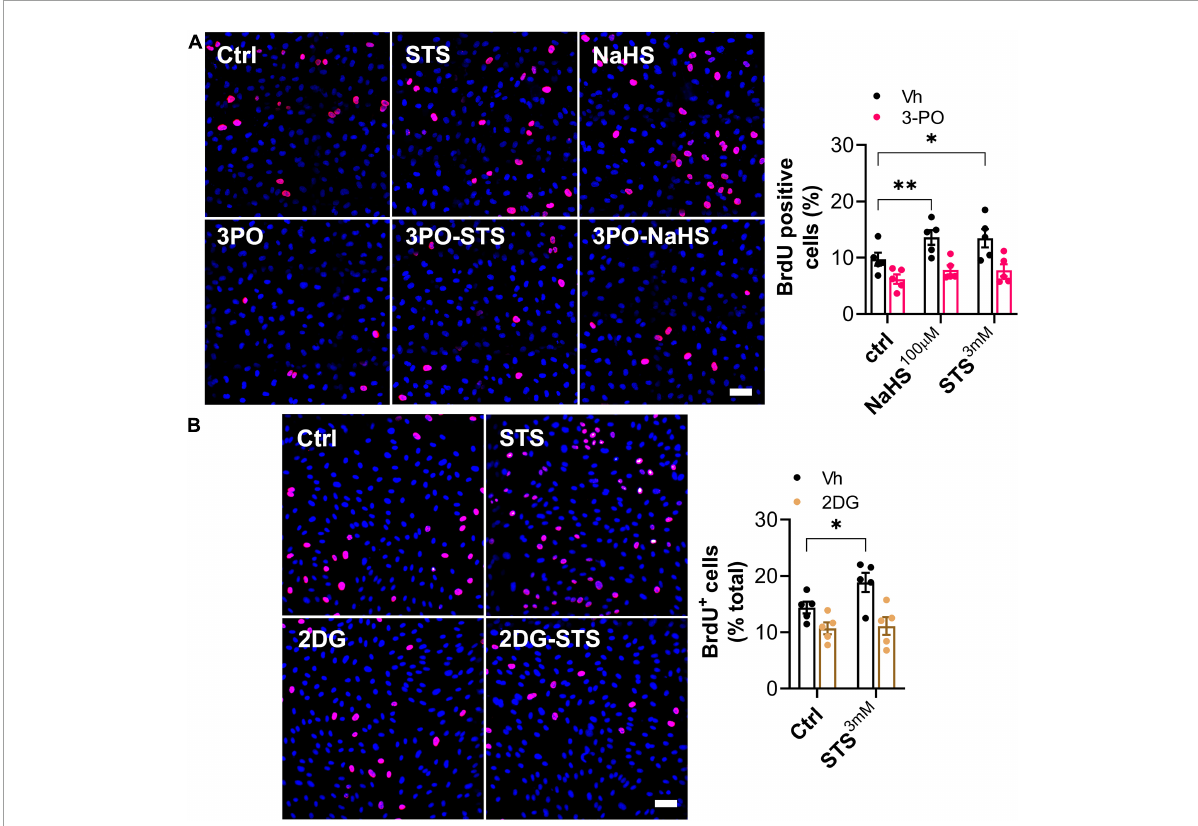
FIGURE6 Sodium thiosulfate (STS)-induced HUVEC proliferation requires glycolysis. (A,B) HUVEC proliferation (BrdU incorporation) in cells treated for 8 h with 100 µ M NaHS, 3 mM STS ± 15 µ M PFKFB3 inhibitor (3-PO) or 6 mM 2 deoxy-glucose (2DG), or their respective vehicle (Vh). Left panels: representative images. Right panels: Data are mean ± SEM of ratio of BrdU positive cells (pink) over DAPI positive nuclei (blue) in five independent experiments. ∗ p < 0.05 as determined by repeated measures two-way ANOVA with Dunnett’s post hoc test.